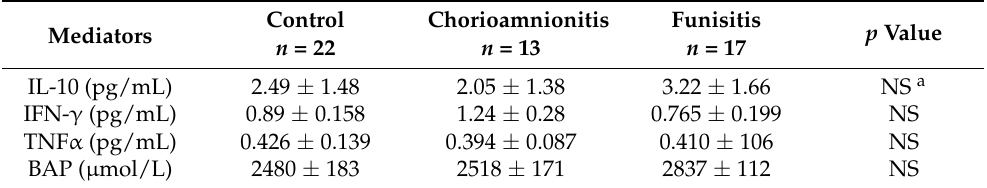
Table 3. Concentration of interleukin (IL)-10 in cord blood, interferon γ (IFN γ ), tumor necrosis factor α , and biological antioxidant potential (BAP) in the newborns studied. Control Chorioamnionitis Funisitis p Value Mediators n = 22 n = 13 n = 17 IL-10 (pg/mL) 2.49 ± 1.48 2.05 ± 1.38 3.22 ± 1.66 NS a IFN- γ (pg/mL) 0.89 ± 0.158 1.24 ± 0.28 0.765 ± 0.199 NS TNF α (pg/mL) 0.426 ± 0.139 0.394 ± 0.087 0.410 ± 106